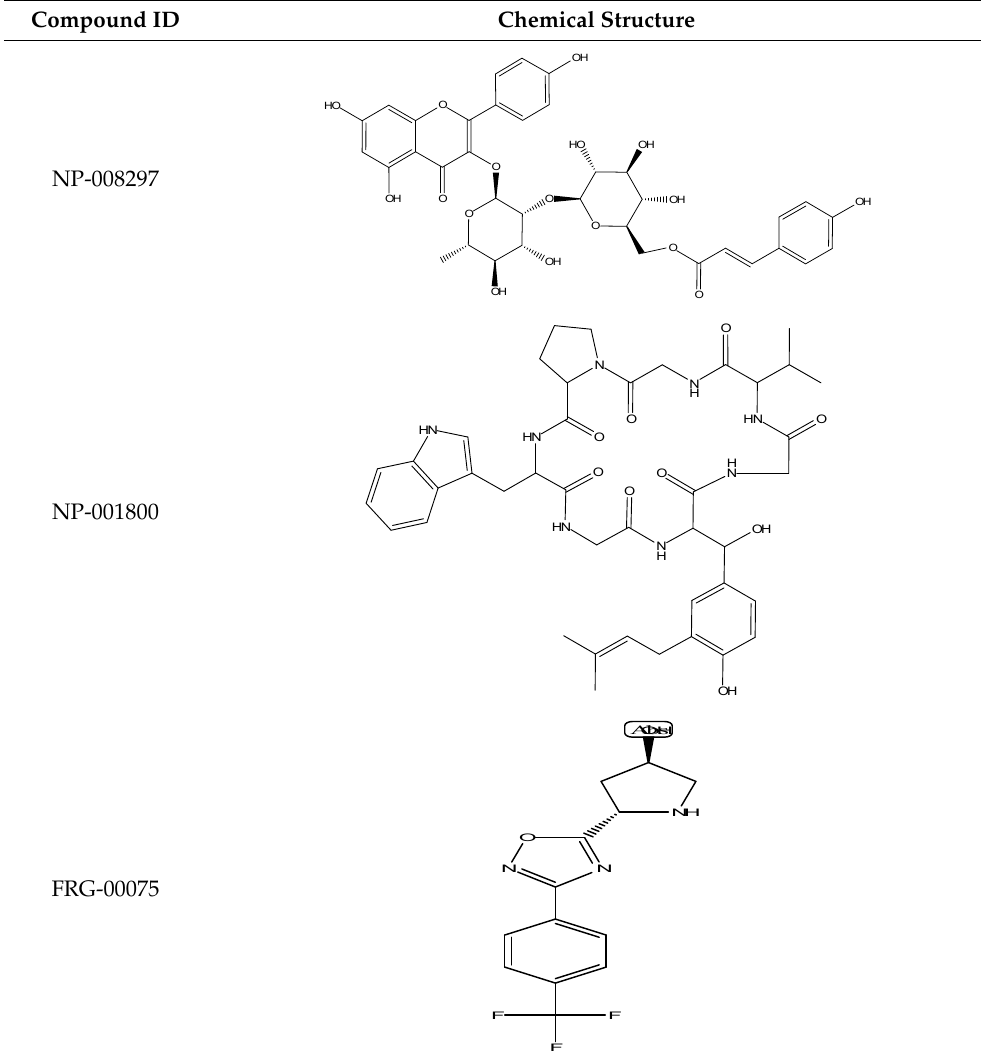
Table 3. Cont. Compound ID Chemical